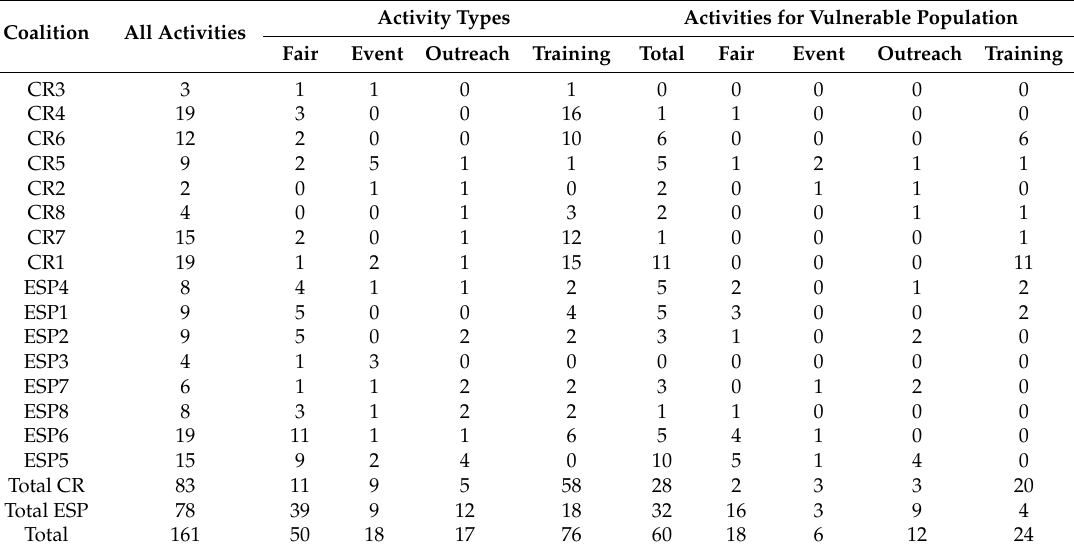
Table 1. Coalition activities by intervention